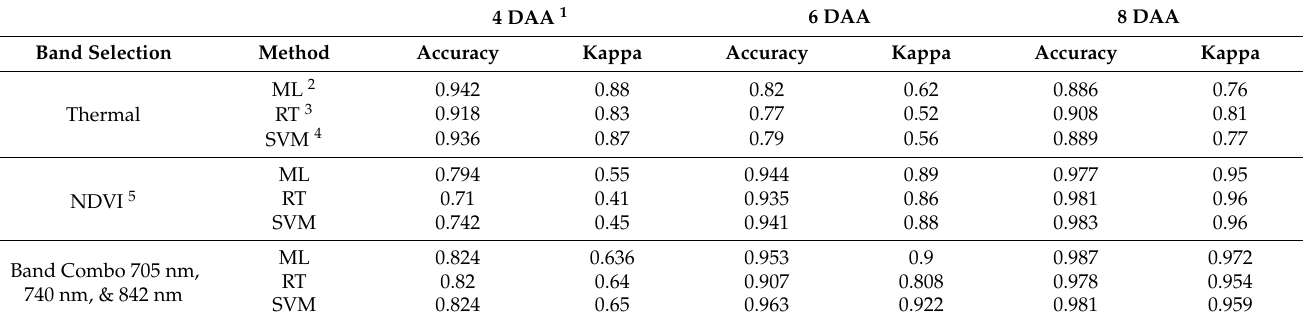
Table 8. Casselton Soybean Classification Performance